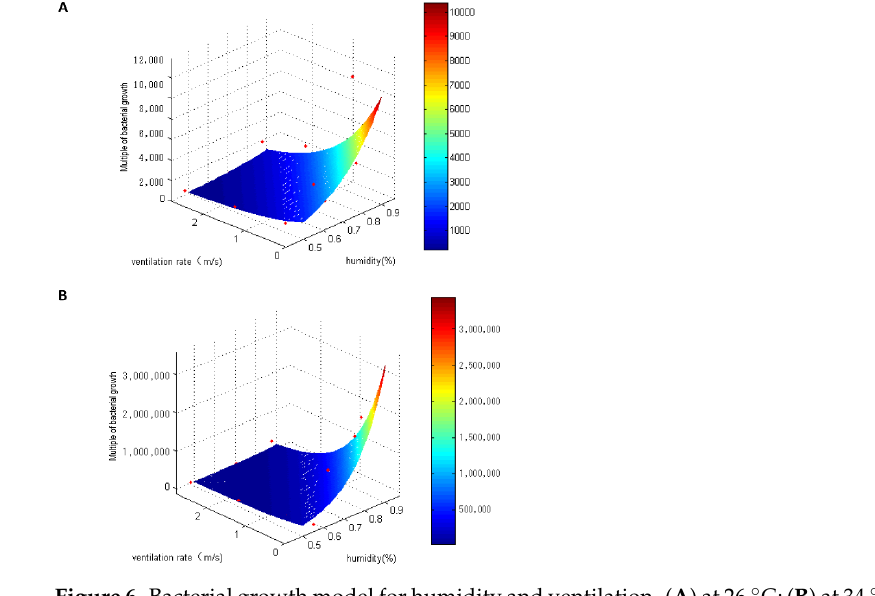
Figure 6. Bacterial growth model for humidity and ventilation. ( A ) at 26 °C; ( B ) at 34 °C. ● represented bacterial growth values in one condition (like 90%, no ventilation).